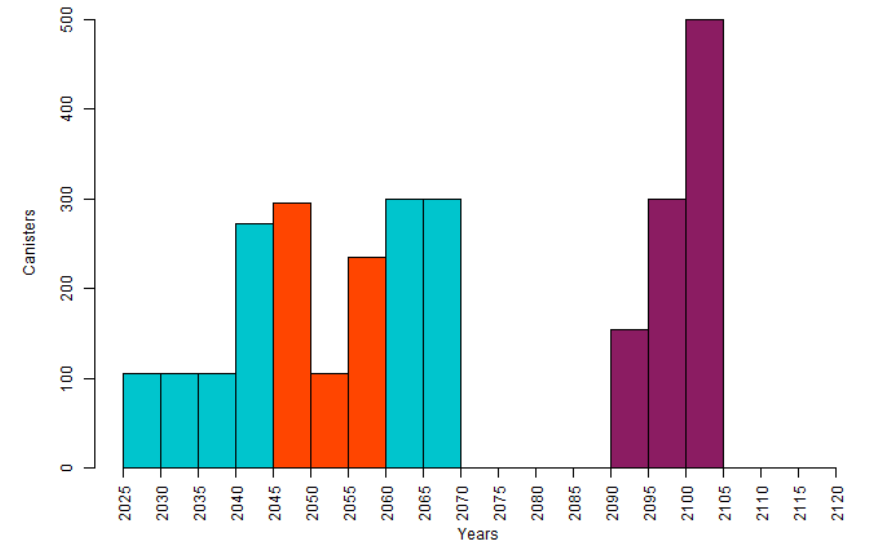
Figure A2. The schedule for the repeatable